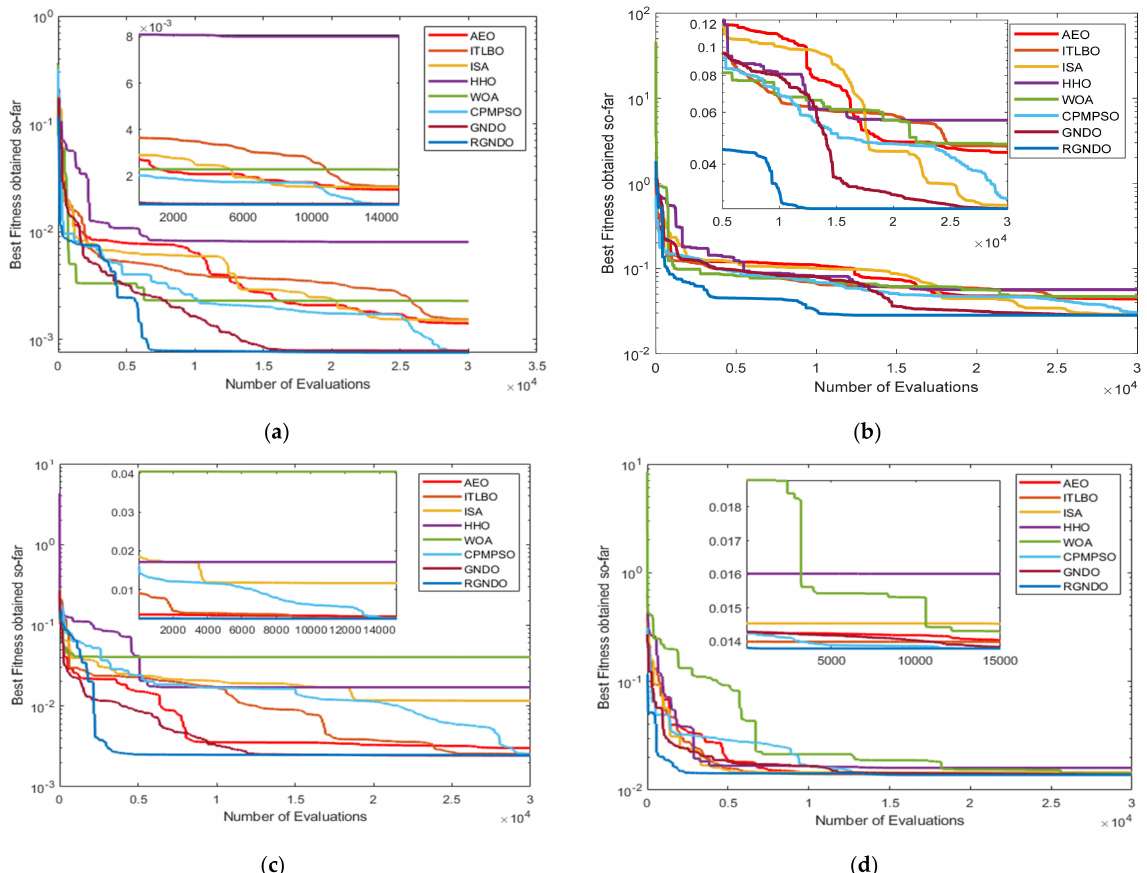
Figure 6. Convergence curves are achieved by the algorithms: ( a ) Convergence on RTC France; ( b ) Convergence on Kyocera KC200GT; ( c ) Convergence on Ultra 85 − P; ( d ) Convergence on STP6 − 120/36.